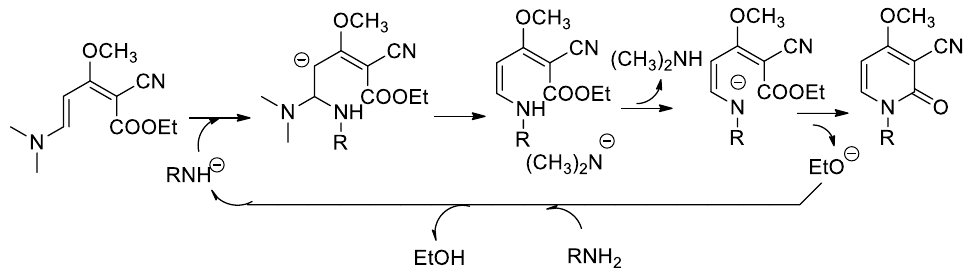
Scheme 6. Mechanism of formation of the pyridinones by basic catalysis.